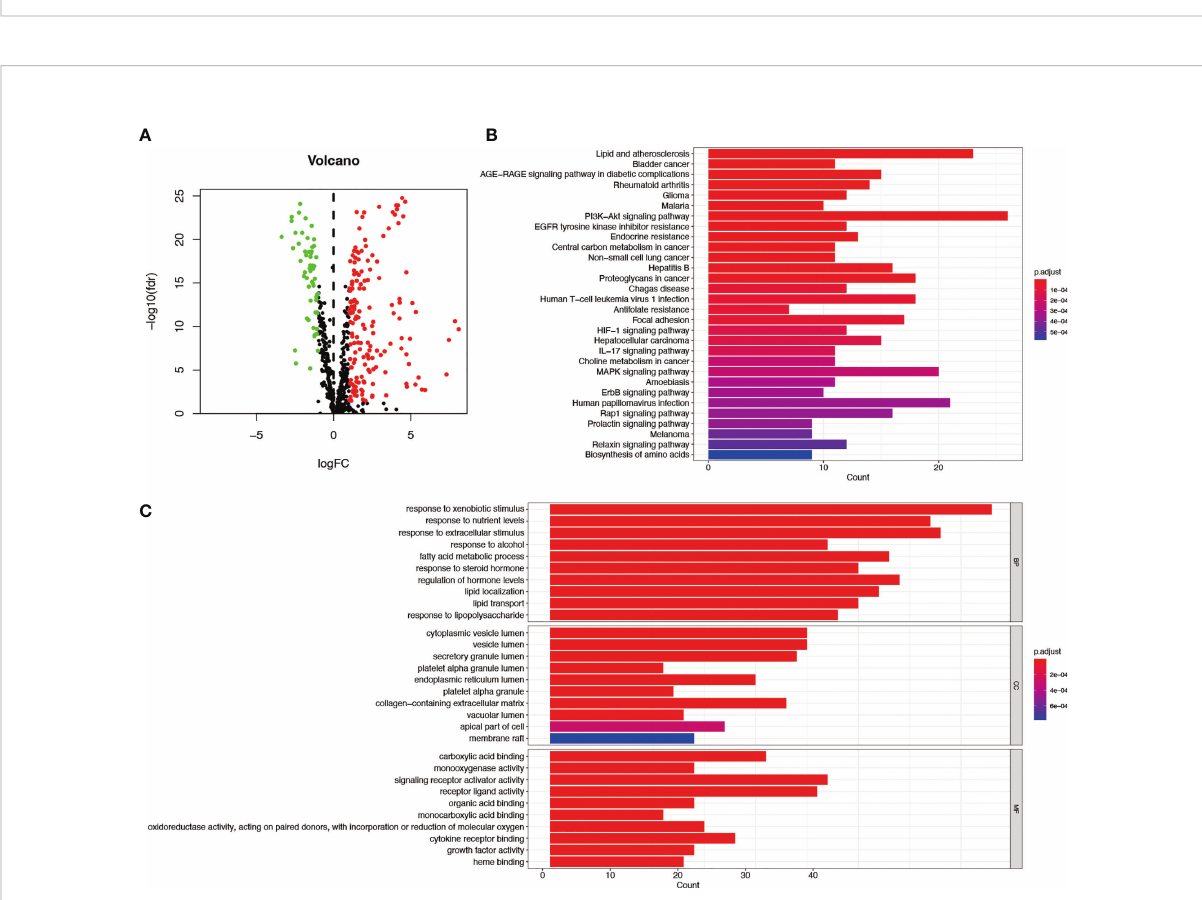
FIGURE 2 GO and KEGG assessments of AME-associated DEGs in tumor and adjacent tissues. (A) Volcano plot of 788 AME-associated genes in liver cancer. Red dots show up-regulated genes, while green dots indicate down-regulated genes. (B) KEGG assessment of AME-associated DEGs. (C) GO evaluation of AME-associated DEGs. FC, fold change; fdr, false discovery rate; BP, biological process; CC, cellular components; MF, molecular function.